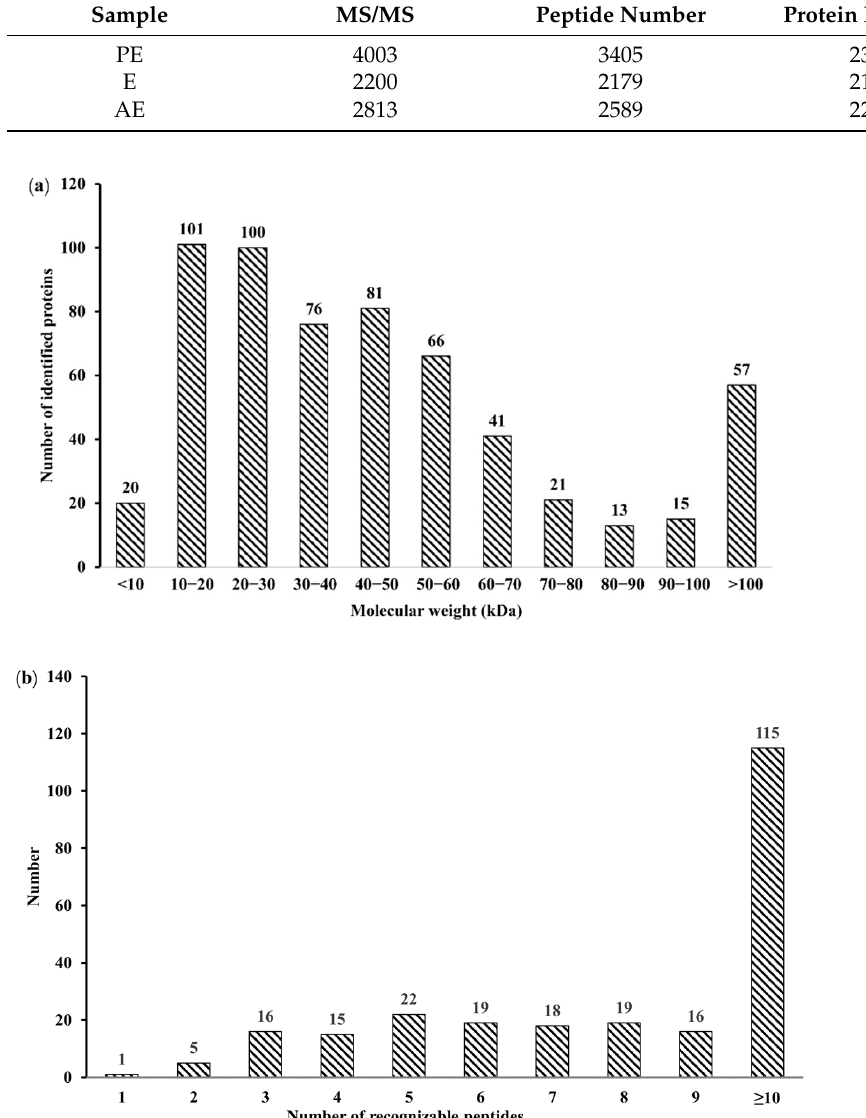
Figure 1. Identification and analysis of salivary proteins during the estrus cycle. ( a ) Number of peptides with different molecular weights. ( b ) Number of proteins recognizing different peptides.